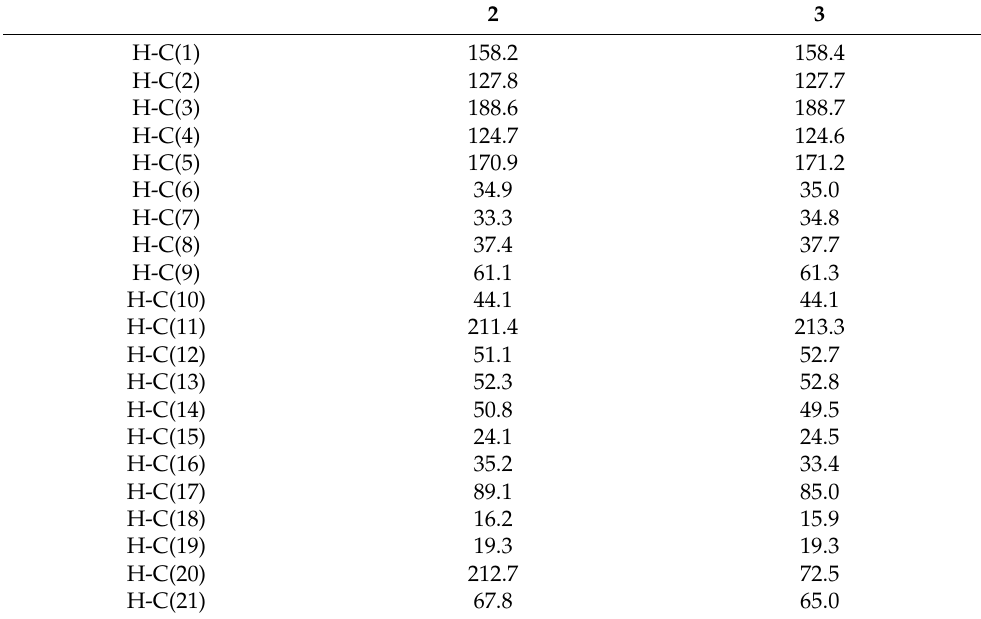
Table 3. 13 C-NMR data of compounds 2 and 3 at 400 MHz in CDCl 3 , δ in